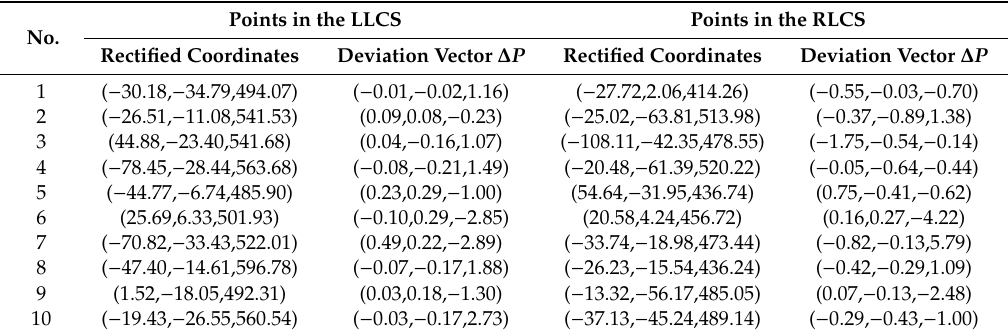
Table 3. Rectified 3D coordinates of the target sphere center in the LLCS and RLCS (mm).